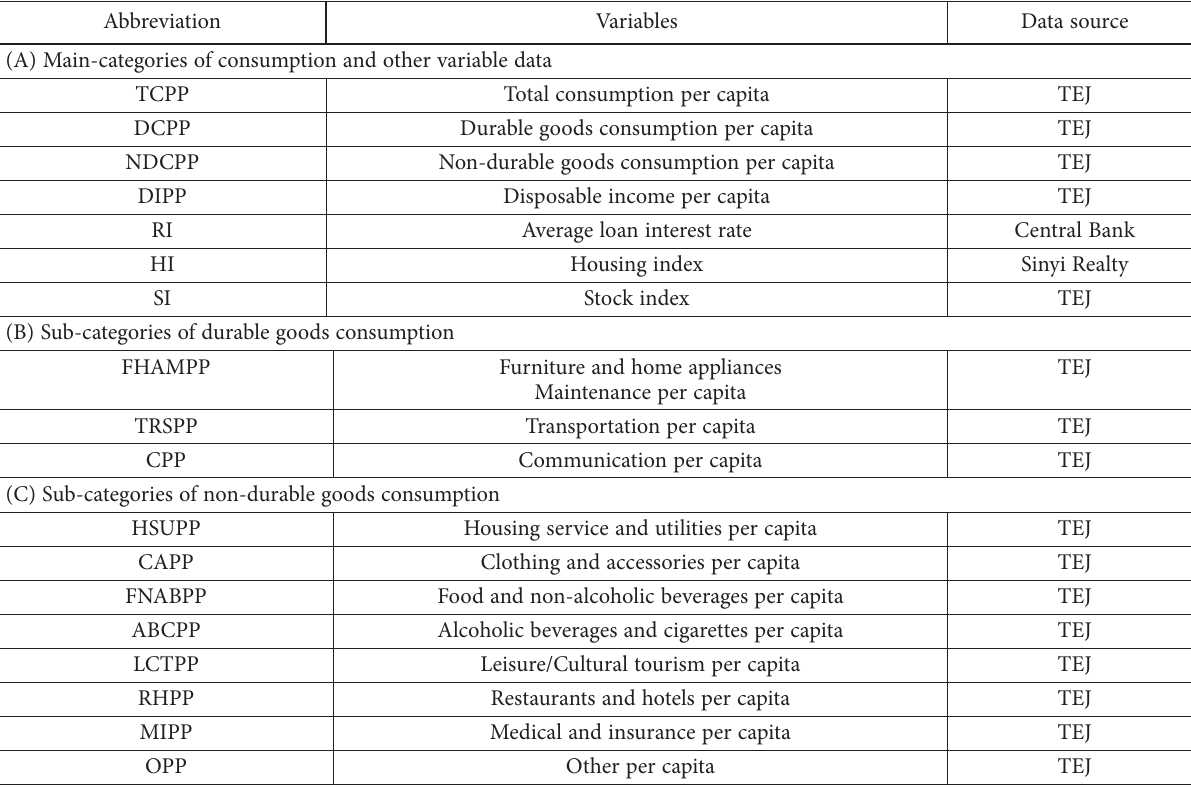
Table 1. Main and sub-categories of consumption: variable data sources (source: Taiwan Economic Journal Database (TEJ),